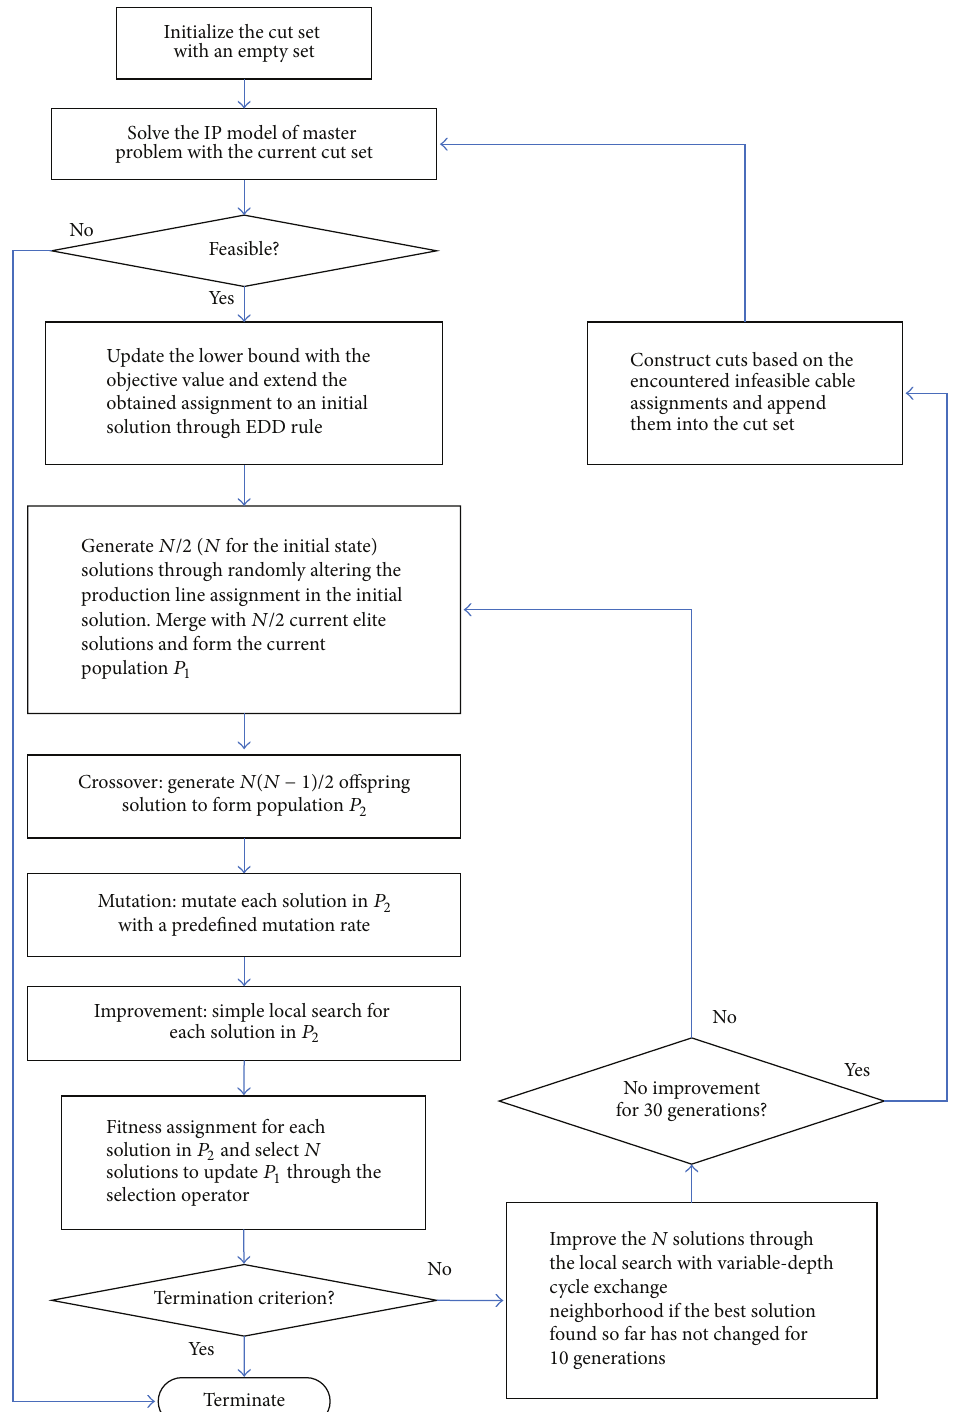
Figure 4: The algorithm framework of the hybrid IP/GA